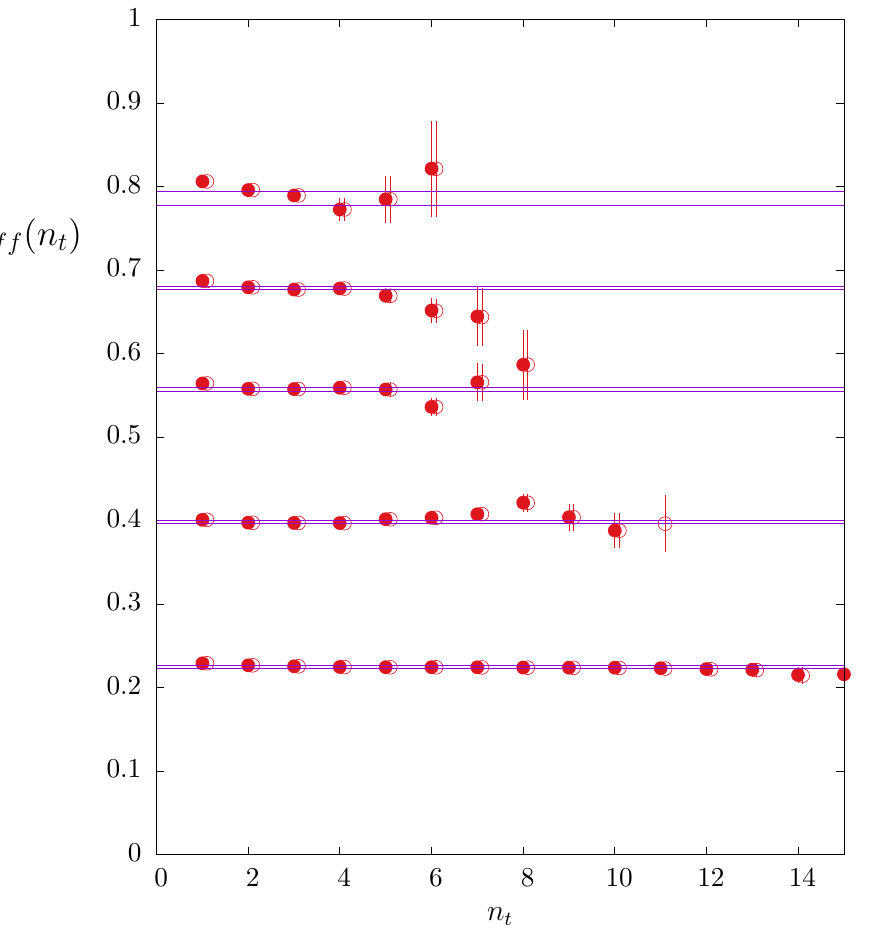
Figure 13 . E(cid:11)ective energy of a (cid:13)ux tube of length l in SO(5) at (cid:12) = 27 : 5, as a function of n t = t=a for l = 14 ; 22 ; 30 ; 36 ; 42. Bands show our energy estimates with errors. Closed (open) points are with (without) vacuum subtraction. (Points shifted for